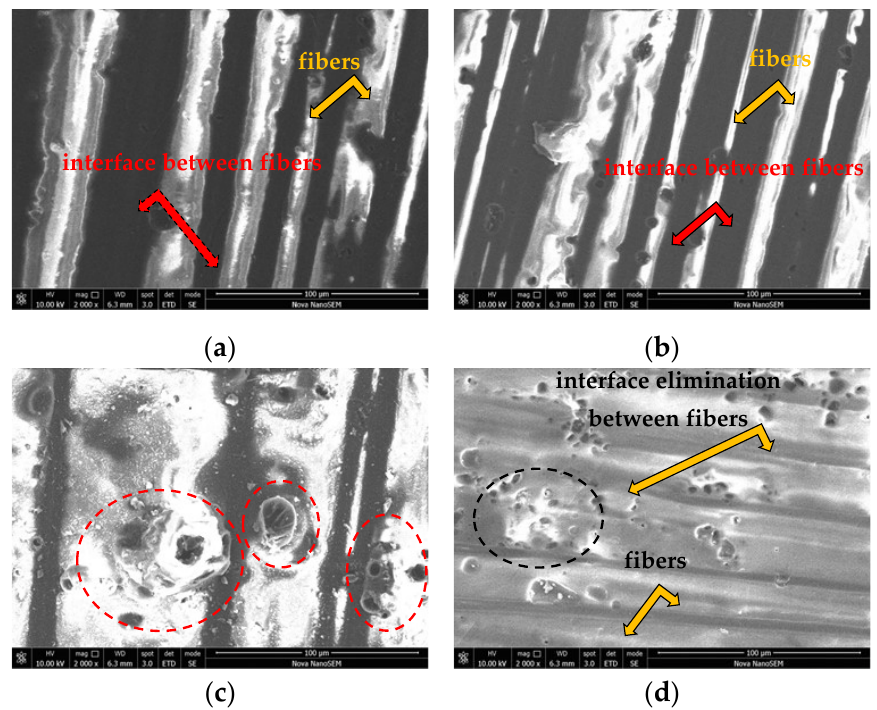
Figure 3. Material surface changes of the experimental CFRP composite; magnification 20× (after 9 weeks); ( a ) reference material before the test; ( b ) after 9 weeks of exposure to 20% NaCl at 60 °C; ( c ) after 9 weeks of exposure to 10% NaOH at 60 °C; ( d ) after 9 weeks of exposure to 15% H 2 SO 4 at 60 °C.